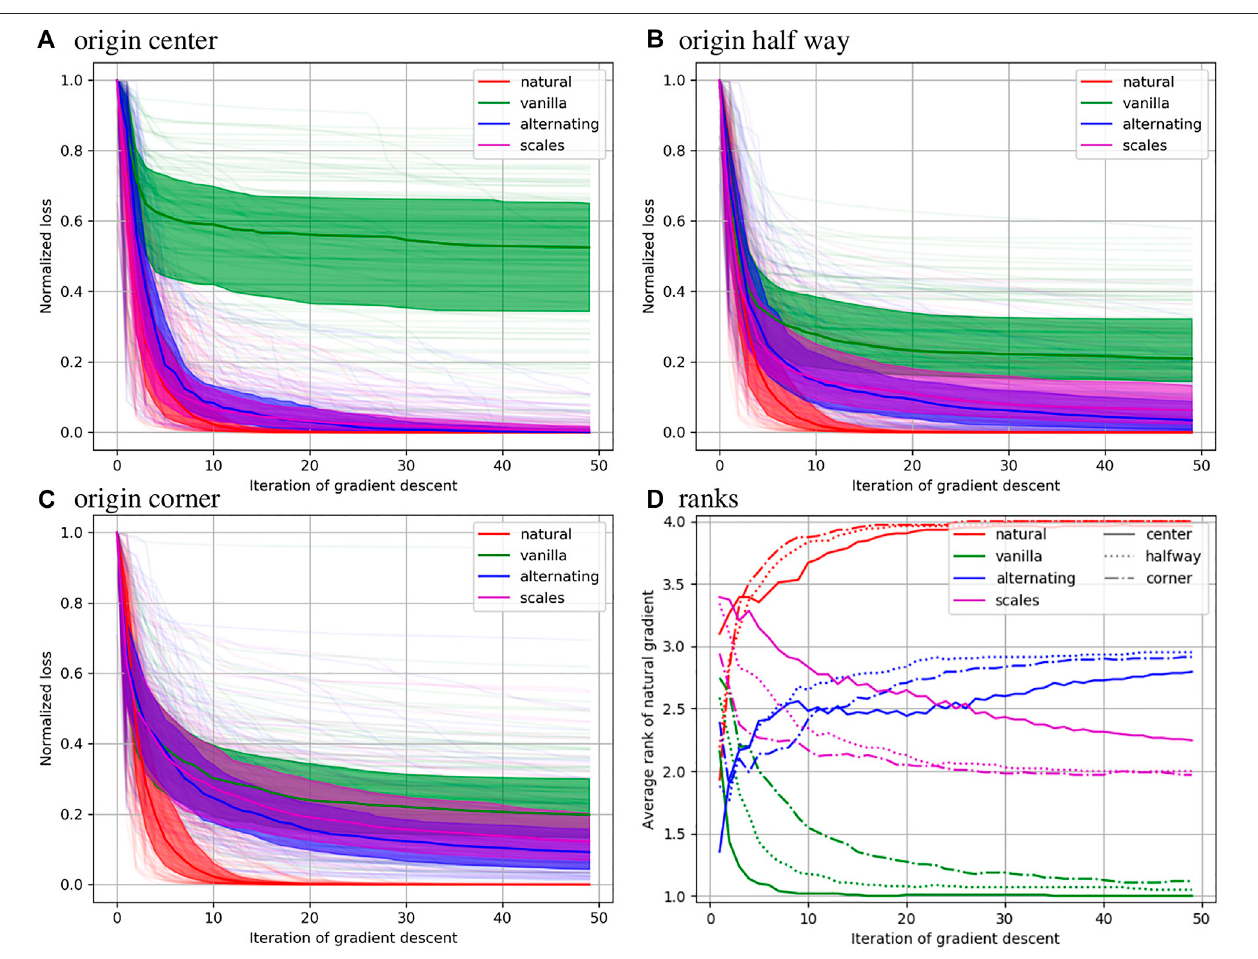
FIGURE 4 | Results of minimizing sum of square error over 12 parameter af fi ne registrations are shown with the coordinate origin in the center (A) , half way to the corner (B) , and in the corner (C) . In these plots the normalized value of the objective function is shown at each iteration of gradient based optimization. In (D) the rank of each method is shown under each of these